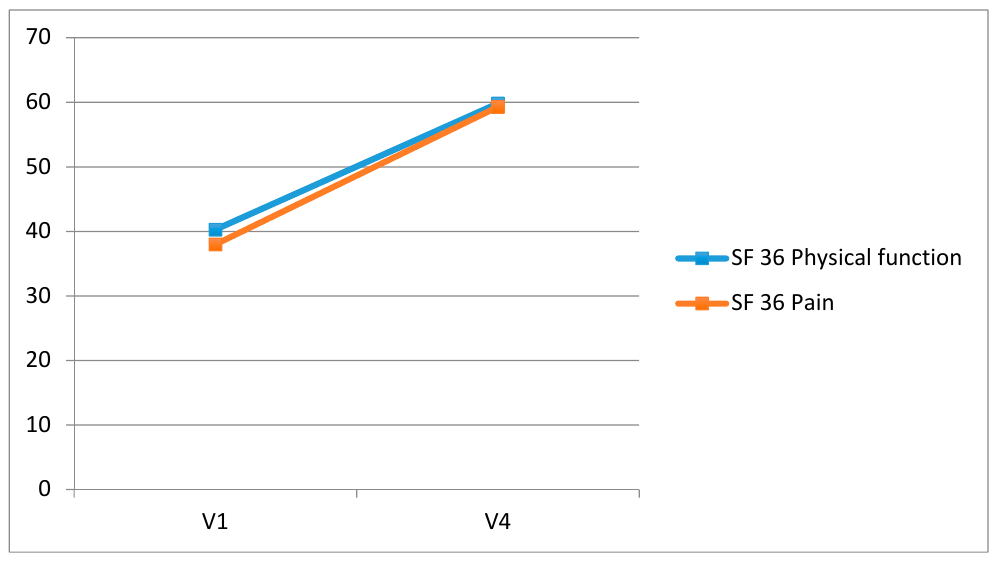
Figure 4. Statistically significant di ff erence between baseline evaluation and 60 days follows-up of the Short Form (36) Health Survey (SF-36) physical functioning score and pain